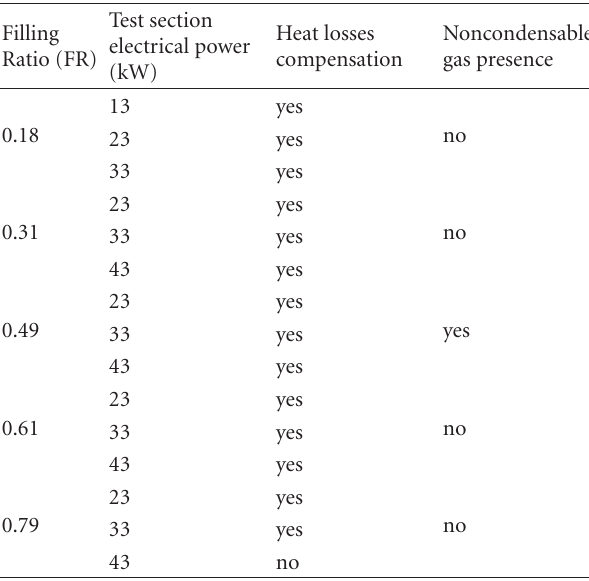
Table 2: Test matrix on IES loop .